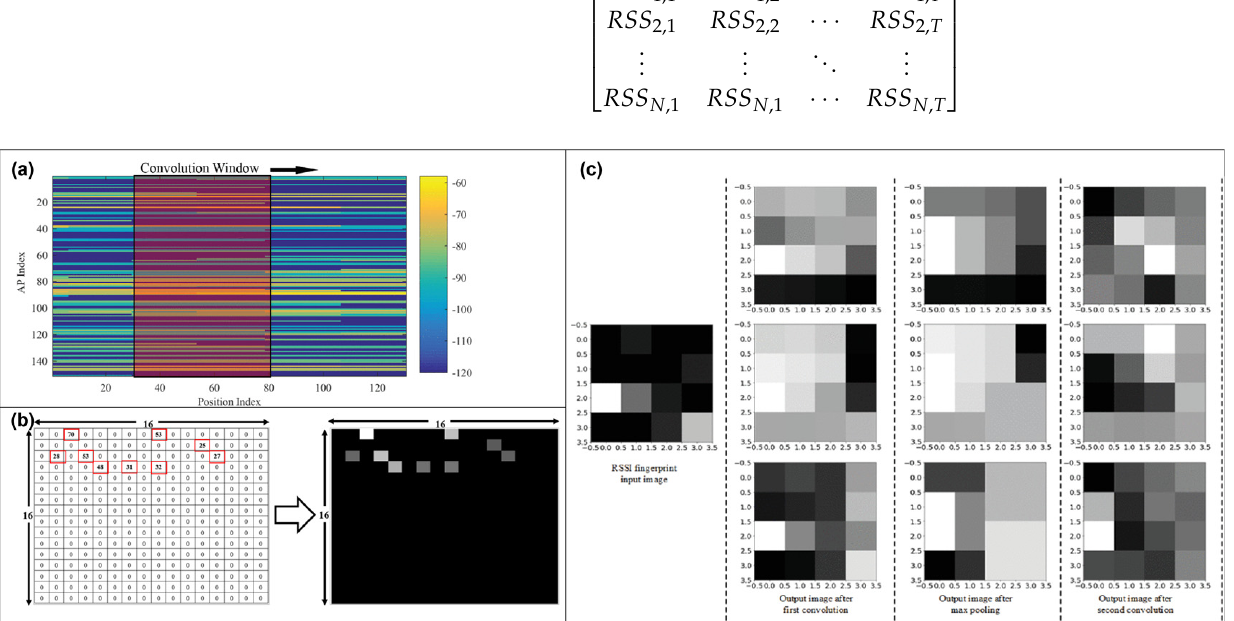
Figure 4. Examples of serialized RSSI transformation for CNN analysis on ( a ) [19], ( b ) [21], and ( c ) [31].